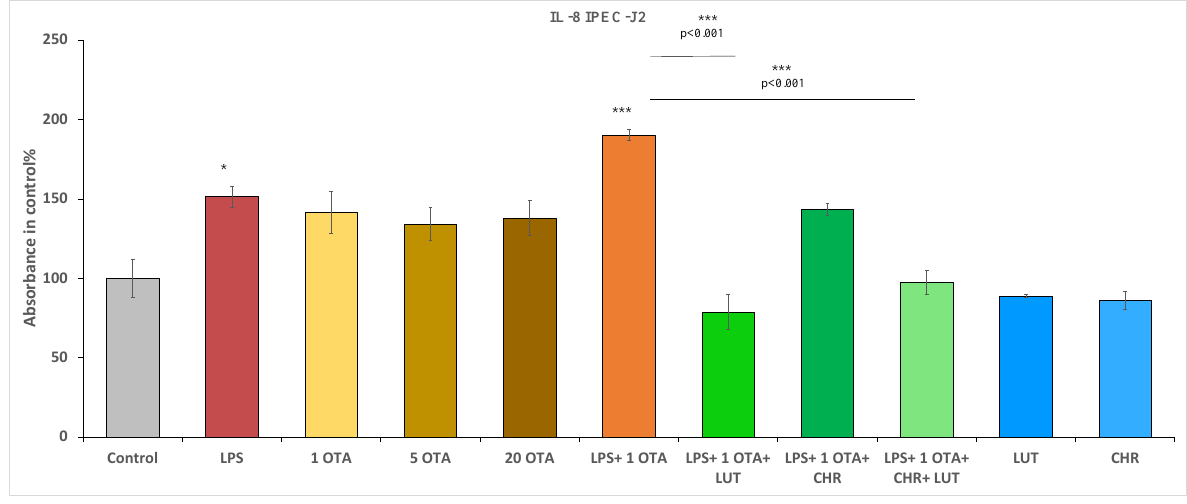
Figure 7. Measurements of interleukin-8 levels after 24 hrs treatment of IPEC-J2 cells with 1 µM OTA, 5 µM OTA, 20 µM OTA, 1 µM CHR, 8.7 µM LUT, 10 µg/mL LPS and their combinations; data are shown as means with SEM; n = 3 samples per group, * indicates p < 0.05, *** indicates p < 0.001. Asterisks alone indicate significant differences between control and treated groups, asterisks with p values underlined show significant changes between the designated groups.